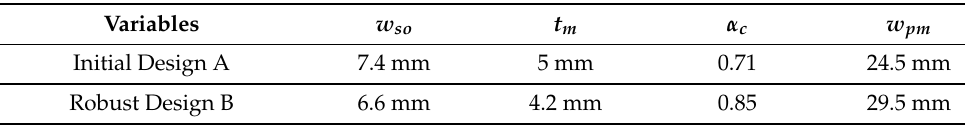
Table 3. Parameter comparison of the initial and optimized motor.